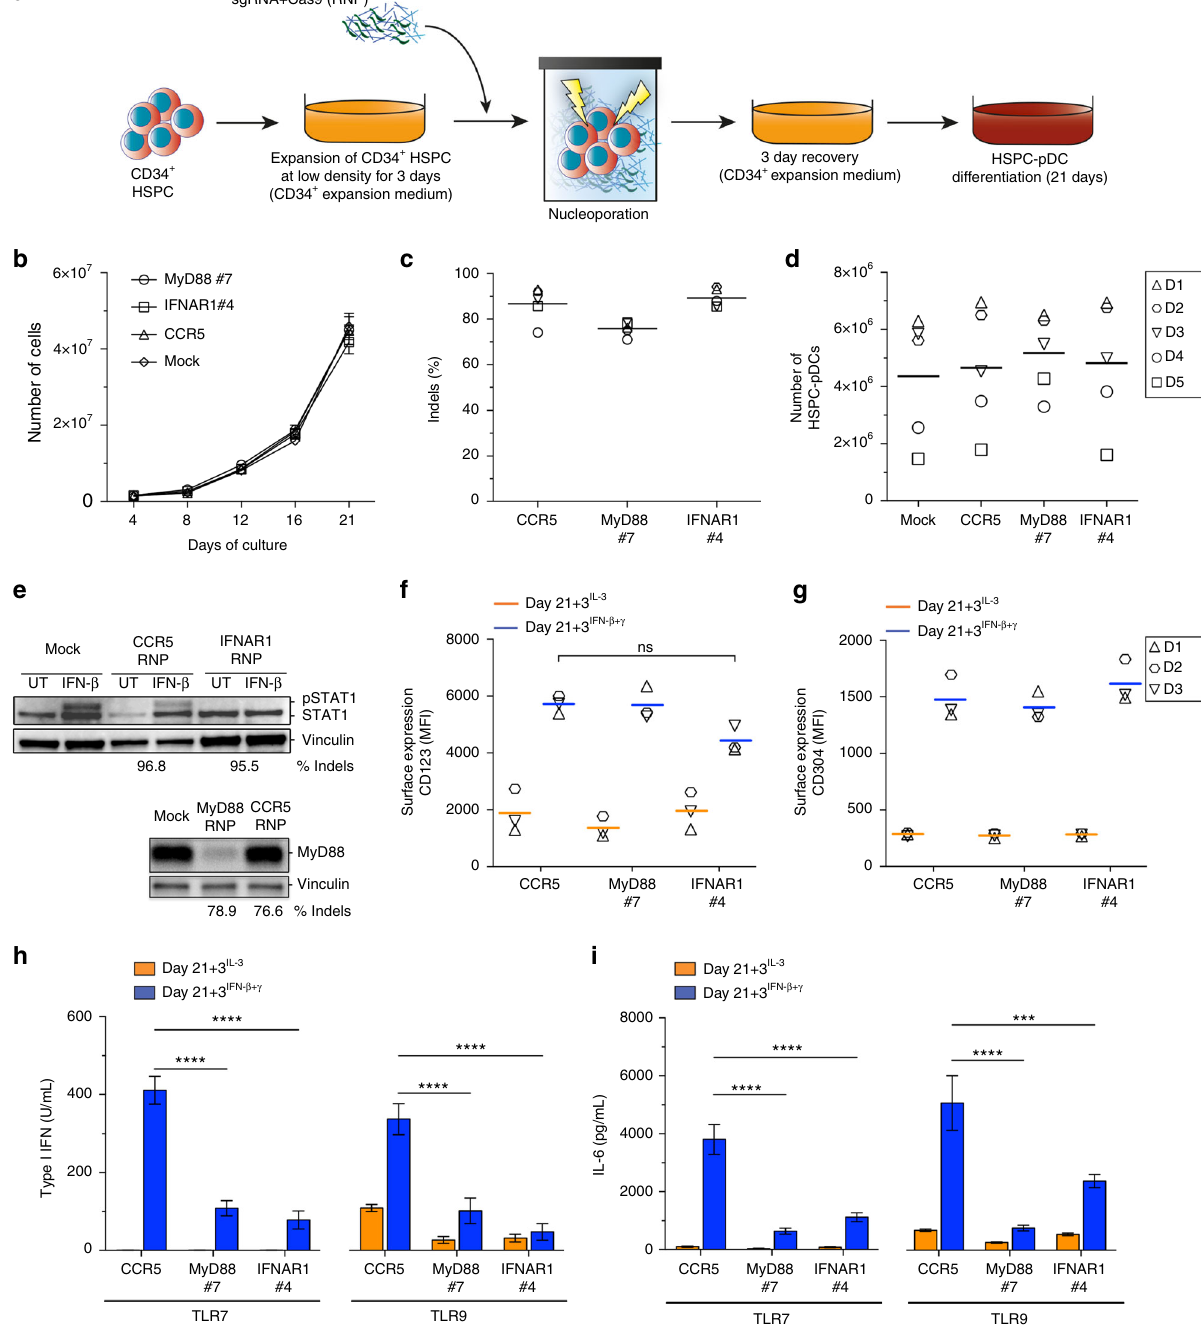
Fig. 6 HSPC-pDCs are amenable to genetic modi fi cations. a Graphical illustration of the protocol for CRISPR/Cas9-mediated gene editing using Cas9 RNP. CD34 + HSPCs were initially cultured in CD34 + HSPC medium at low density for 3 days before being electroporated with Cas9 RNP complexes. After a 3-day recovery phase, pDC differentiation was initiated. b Expansion of cells during differentiation from HSPCs into HSPC-pDCs. c Indel frequencies after the 3-day recovery phase quanti fi ed by TIDE analysis for cells targeted at MyD88 , IFNAR1 , and CCR5 (control). d Numbers of HSPC-pDCs at day 21 for gene-edited HSPC-pDCs. e Western blot analysis showing induction of pSTAT1 upon 3 h IFN- β stimulation (upper panel) and protein levels of MyD88 (lower panel) in HSPC-pDCs targeted at IFNAR1 and MyD88 , respectively (detection Ab for STAT1: CST 9172). Indel frequencies at the respective targets are listed below the western blot. f , g Surface expression levels (MFI) of CD123 ( f ) and CD304 ( g ) in IFN-primed and unprimed HSPC-pDCs with gene editing at MyD88 , IFNAR1, and CCR5 . h Functional levels of type I IFN after stimulation with R837 (TLR7) or CpG-A (TLR9) in unprimed and IFN-primed HSPC-pDCs gene-edited at CCR5 , MyD88 , or CCR5 . i Levels of IL-6 after stimulation with R837 (TLR7) or CpG-A (TLR9) in unprimed and IFN-primed HSPC-pDCs targeted at CCR5, MyD88, or IFNAR1 . Data are ±SEM of fi ve ( b – d ) or three ( f – i ) donors. Statistical analysis was performed using regular